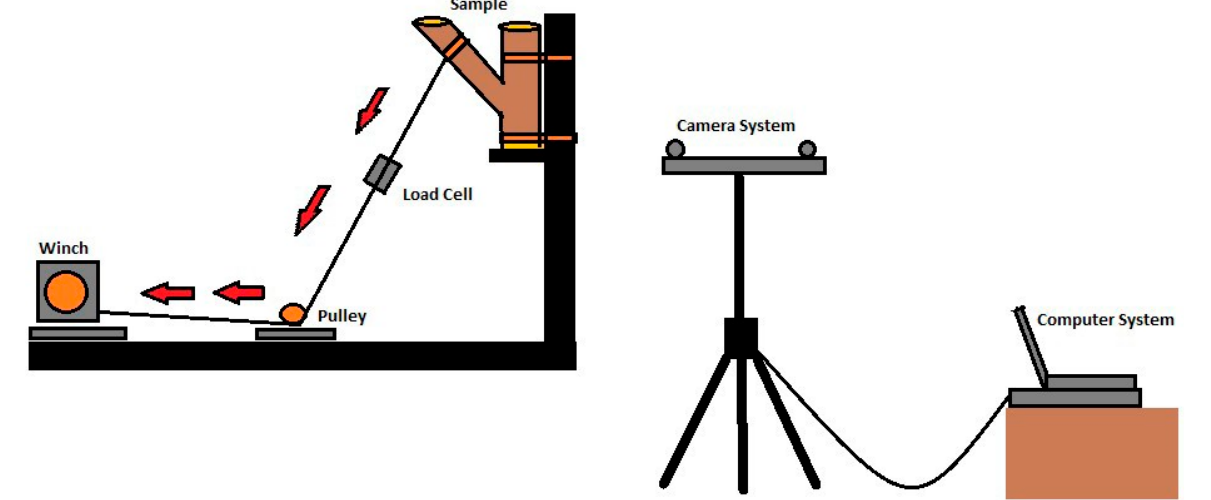
Figure 1 . A diagram of the static branch pull system. Red arrows indicate direction of winch pull.